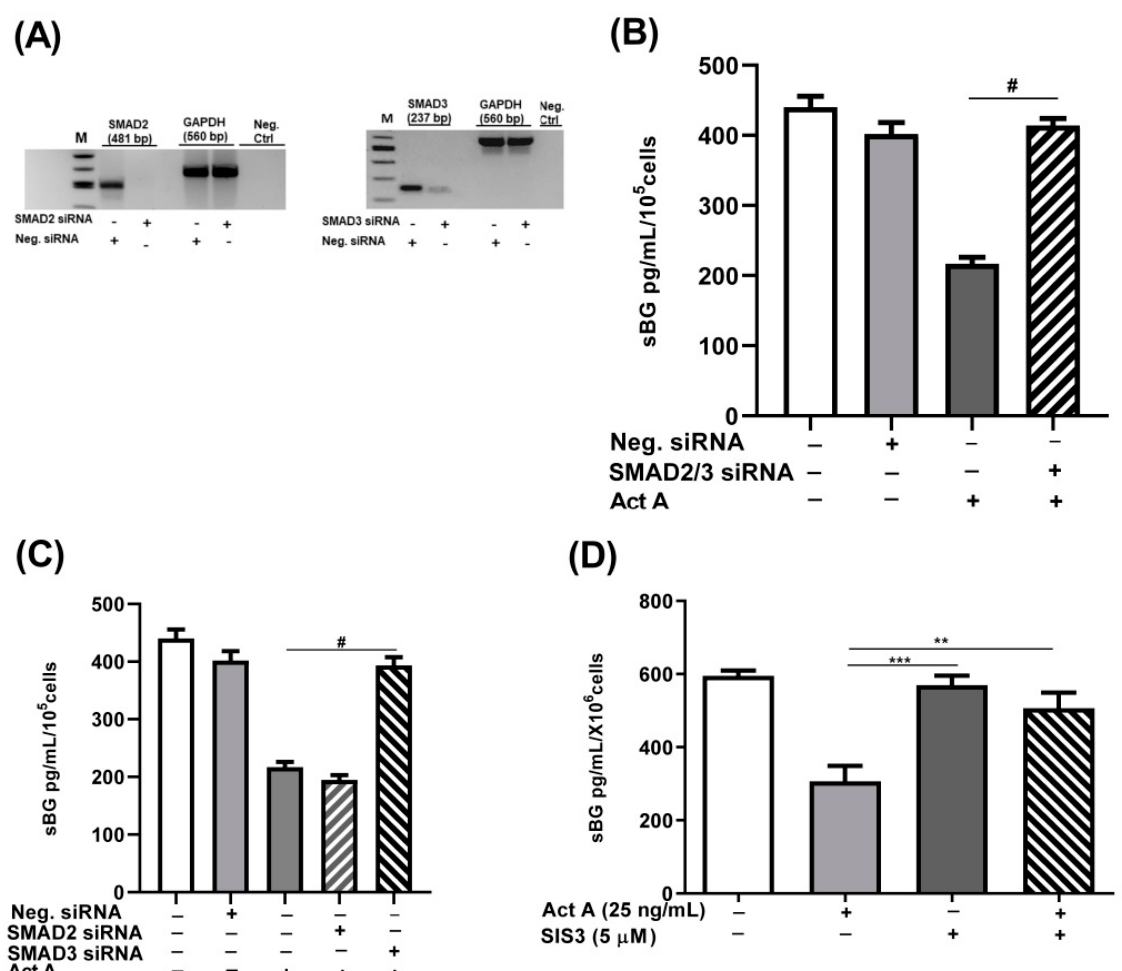
Figure 5. Activin A-mediated reduction in BG shedding is SMAD3- but not SMAD2-dependent. Epithelial 12Z cells were plated in 6-well plates and transfected with SMAD2 siRNA, SMAD3 siRNA, or negative control siRNA. RT-qPCR of the gene silencing efficiency for each siRNA was performed to ascertain the silencing of SMAD2 and SMAD3 ( A ). SMAD2/3 double-silenced and single-silenced 12Z cells were subsequently stimulated with activin A (25 ng/mL) for 48 h and supernatants were analyzed by sBG ELISAs. SMAD2/SMAD3 double gene knockdown significantly abrogated the activin A-dependent reduction in BG shedding ( B ). Single gene knockdown revealed that only the silencing of SMAD3 and not of the SMAD2 gene blocked the activin A-mediated effects ( C ). These results were further corroborated using the specific inhibitor of SMAD3, SIS3 (5 µ M) ( D ). Untreated cells and cells treated with Neg. siRNA or DMSO (0.01%) were used as controls. Each bar represents the mean ± SEM of 3 independent experiments performed in duplicate. Dunnett’s test was used for statistical analysis; ** p < 0.01; *** p < 0.001; # p < 0.0001; siRNA, small interfering RNA; Neg. siRNA, negative control siRNA; sBG, soluble betaglycan; Act A, activin A. 3.5. Influence of Activin A and Inhibin A in MMP2 and MMP3 Secretion